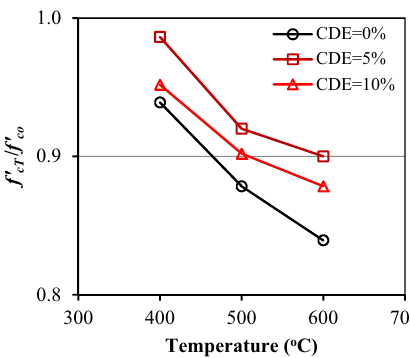
Figure 19: Degradation of compressive strength due to high - temperature